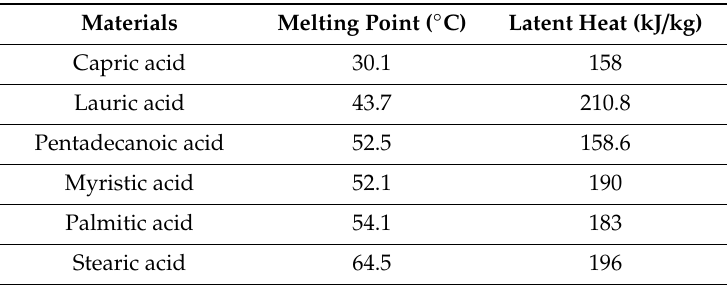
Table 2. Thermal physical properties of some fatty